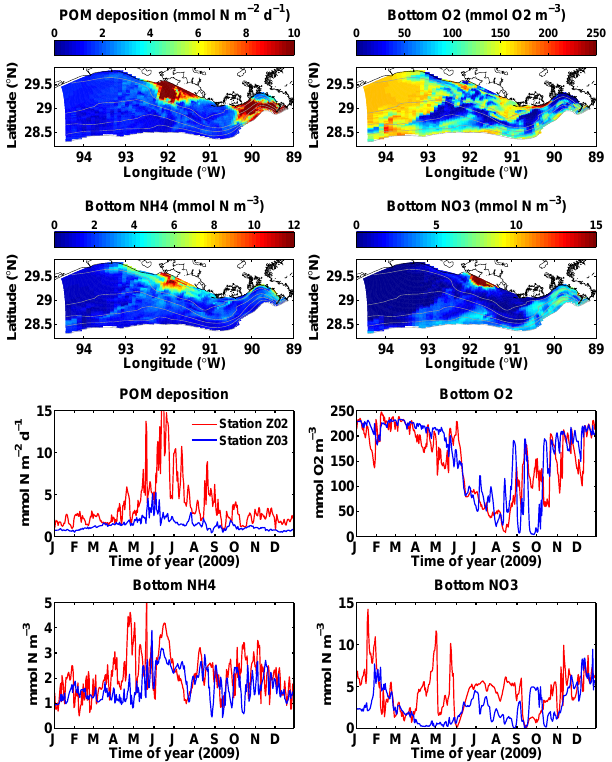
Figure 3. Spatial (top) and temporal (bottom) POM depositional flux and bottom water O 2 , NH + and NO − concentrations in the 4 3 biogeochemical circulation model. The upper panels represent a snapshot of bottom water conditions on 15 August 2009 and the lower panels time series at stations Z02 and Z03. This data set is used to force the diagenetic model in the meta-modeling pro- cedure (Sect. 2.2), to compute spatial fluxes with the meta-model (Fig. 8) and to compare the meta-model and H&D parameteriza- tions (Fig.